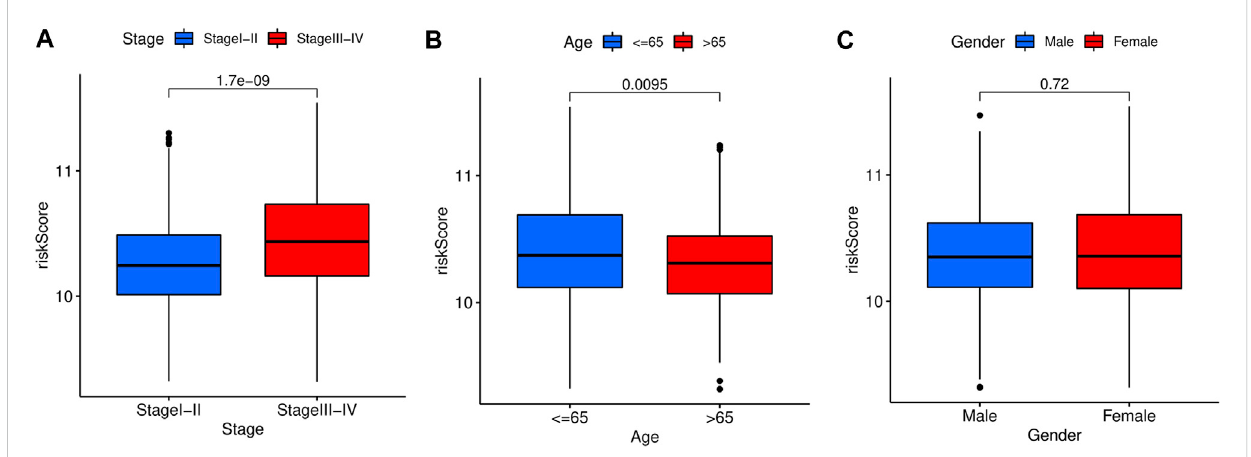
FIGURE 6 Strati fi ed analysis of the prognostic signature in the training cohort. The relationships between the FAS and age (A) , gender (B) , stage (C) .